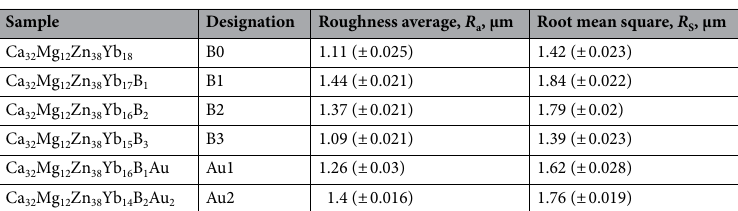
Table 1. Surface roughness parameters for the Ca 32 Mg 12 Zn 38 Yb 18-x B x (x = 0, 1, 2, 3 at.%) and Ca 32 Mg 12 Zn 38 Yb 18-2x B x Au x (x = 1, 2 at.%)